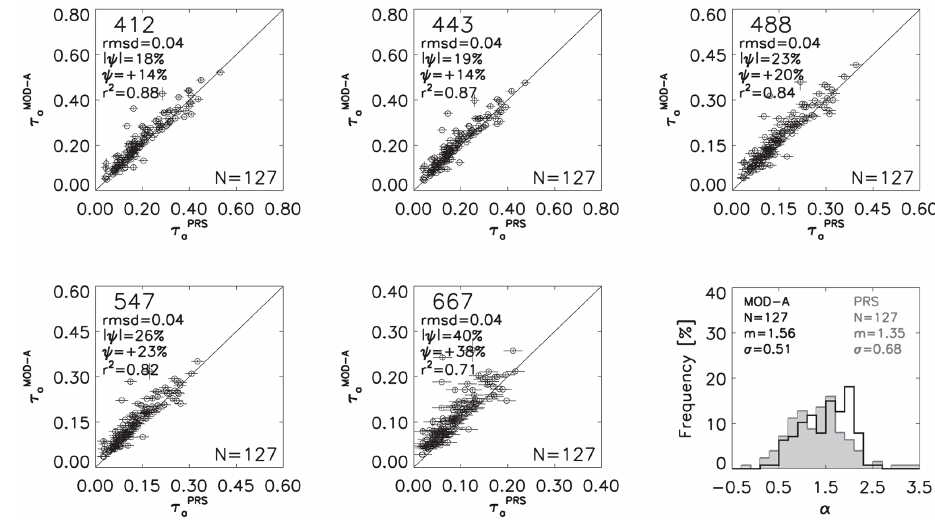
Figure 7. Scatterplot of MODIS-A (MOD-A) versus AERONET-OC (PRS) τ a at selected center wavelengths for the GLR site. N indicates the number of match-ups, τ a and RMSD are dimensionless, and | ψ | is the mean of absolute percent differences, while ψ is the mean of percent differences, and r 2 is the determination coefficient. The right panel in the second row displays frequency distributions of α determined from τ a at 748 and 869nm for MODIS-A, and 667 and 870nm for PRS. The black characters and empty bars in the frequency distribution plot indicate results from the analysis of MODIS-A data, while the grey characters and the solid bars indicate results from the analysis of AERONET-OC data ( m is the median and σ the standard